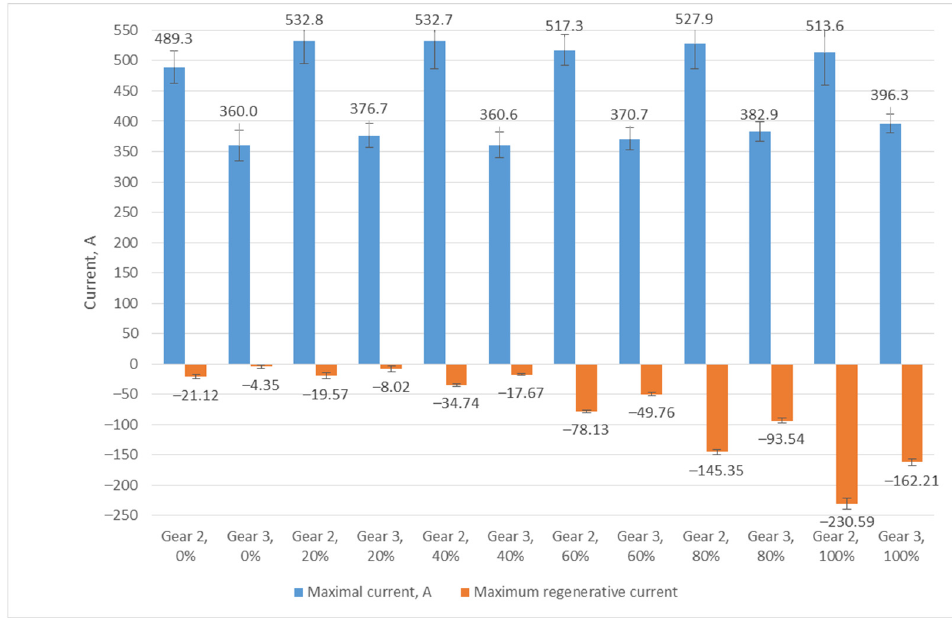
Figure 6. Maximum current when accelerating and applying regenerative braking.